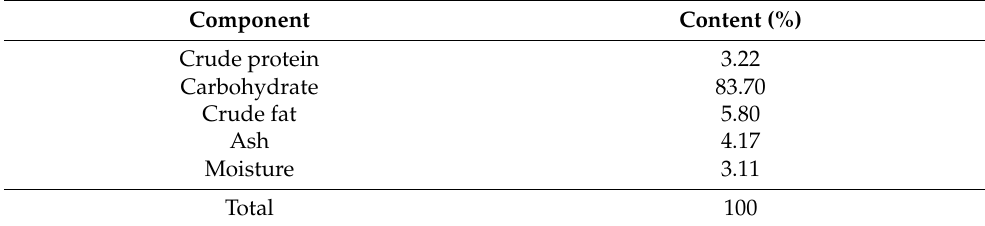
Table 1. Composition of the